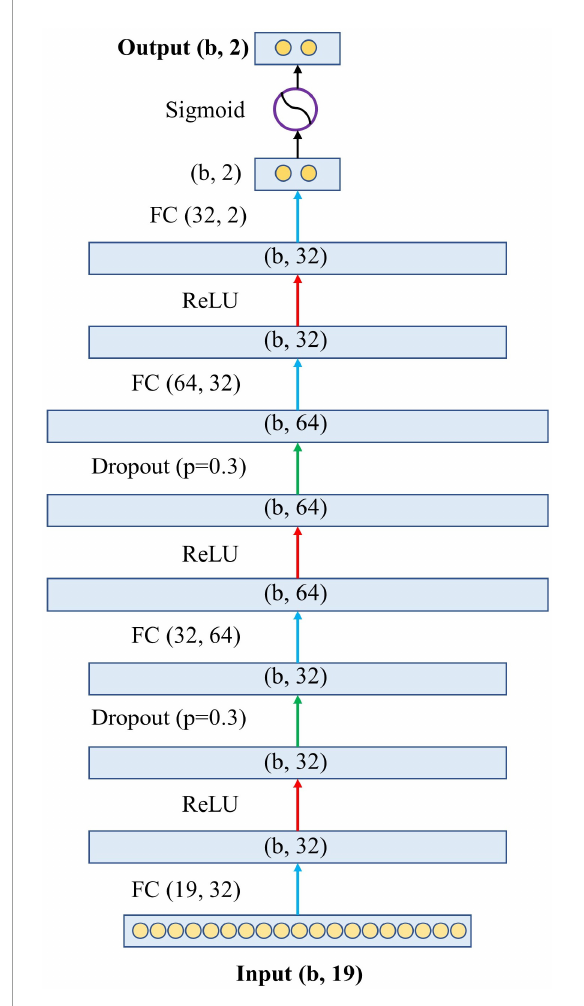
FIGURE2 The architecture of the proposed neural network. The letter “b” in the figure represents the batch size of the model, which is the number of samples used to train a single forward and backward pass. FC, fully connected layer; ReLU, rectified linear